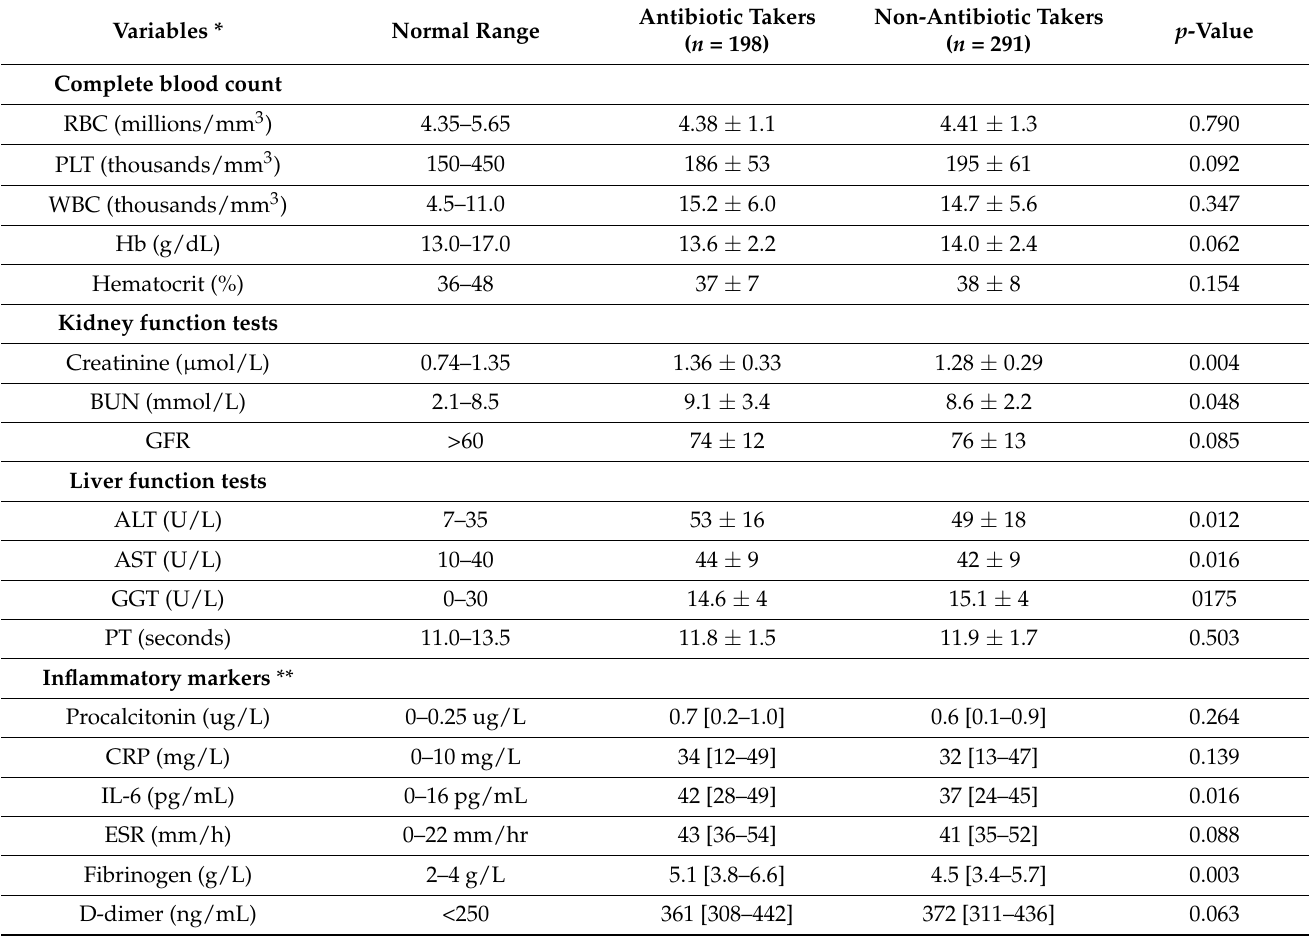
Table 3. Biological parameters at admission of COVID-19 patients with secondary bacterial infections stratified by antibiotic use